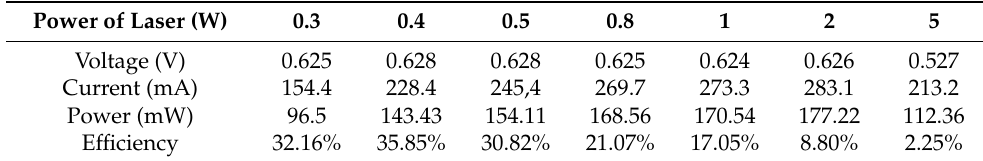
Table 1. The conversion efficiency of a single photovoltaic